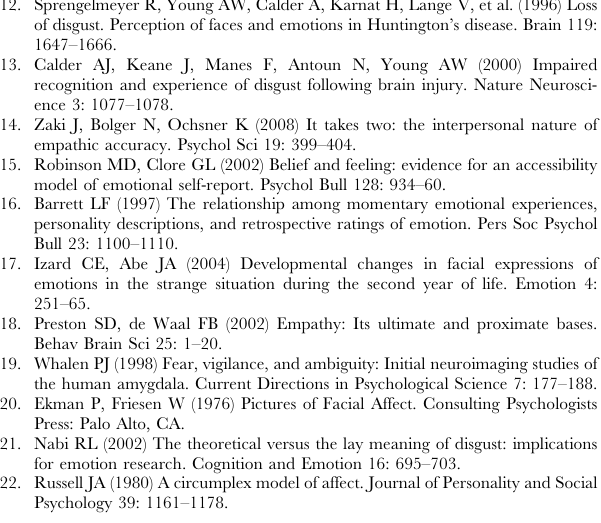
A: happy, B: surprise, C: fear, and D: anger. X-axes represent the numerical location of the slider placement relative to the prototype for each expression. Y-axes represent the number of participants across the whole sample who chose a particular face morph. Arrows on each x-axis denote the location of the prototypical facial expression for each emotion. Table S1 Age Distribution Across Fear Experience Groups. The table shows the age distributions of the different fear experience groups (numbers indicate the number of participants within each age group who were in each fear experience